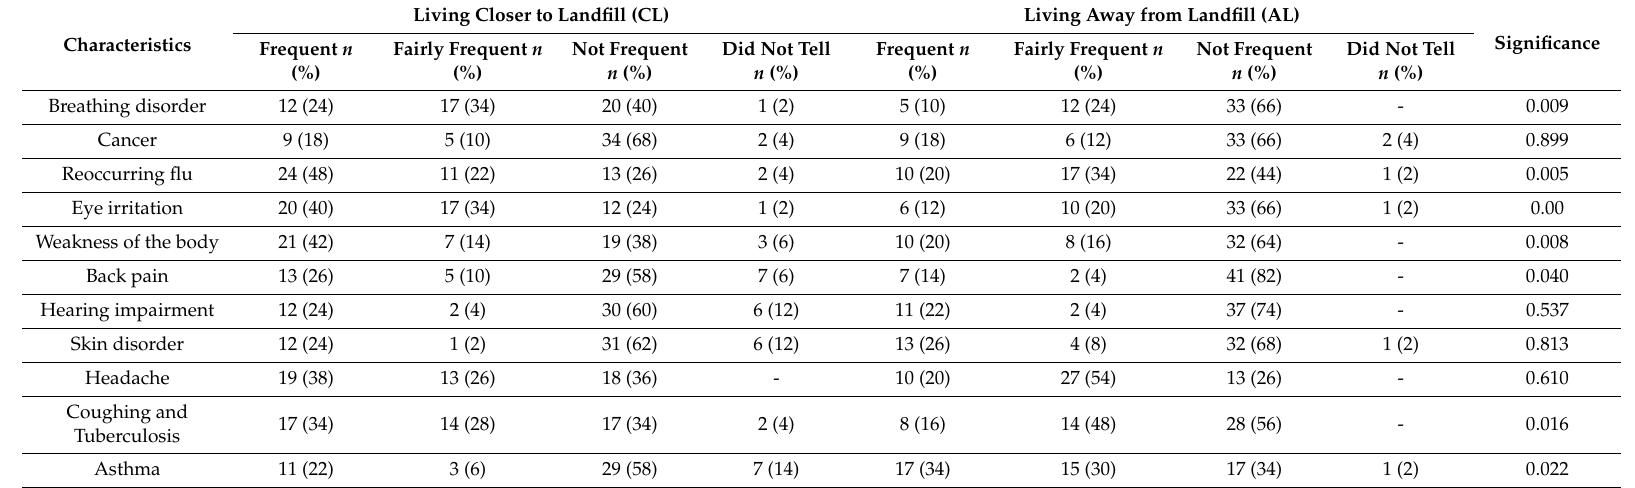
Table 3. Respondents’ rating of how these illnesses are reported by the participants in both